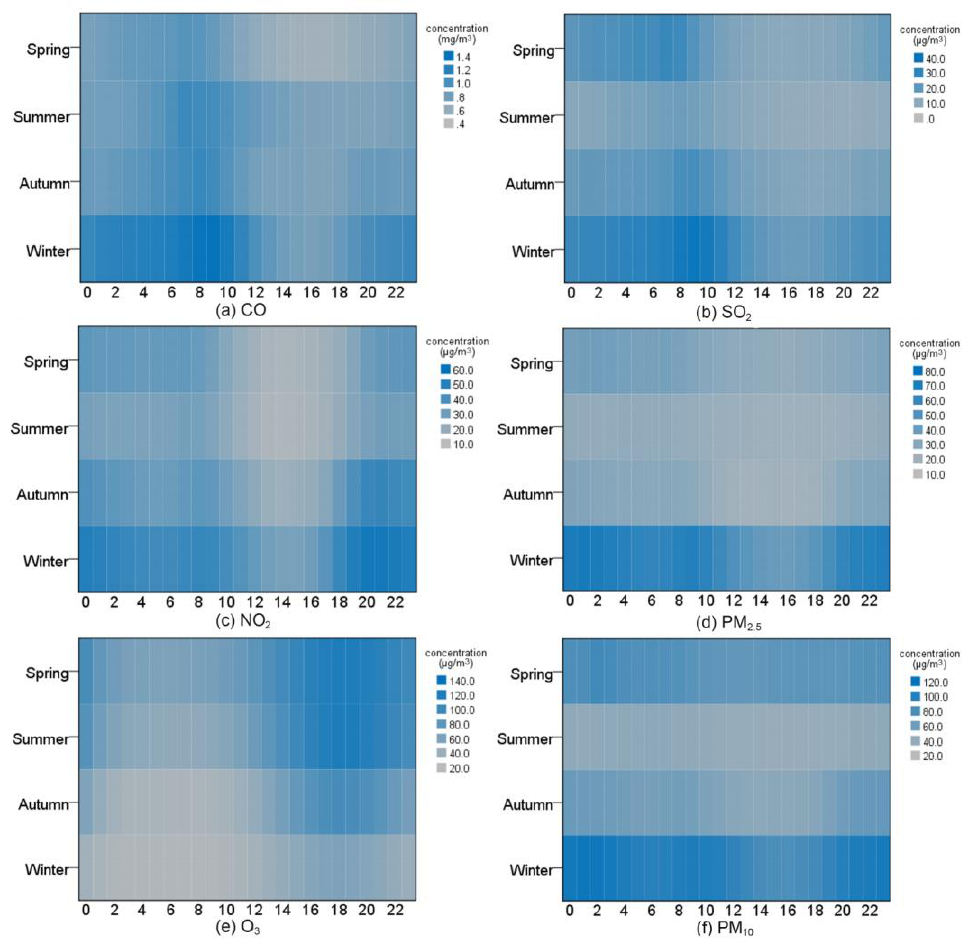
Figure 4. Diurnal variation of concentrations of the six pollutants in different seasons in 2019: ( a ) CO, ( b ) SO 2 , ( c ) NO 2 , ( d ) PM 2.5 , ( e ) O 3 , ( f ) PM 10 .